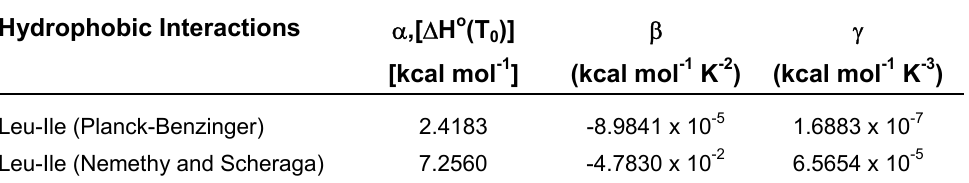
Values of ∆ H o (T ) and Expansion Coefficients for the Hydrophobic Interaction of 0 Leu-Ile, Comparing the Planck-Benzinger and Nemethy-Scheraga Approaches